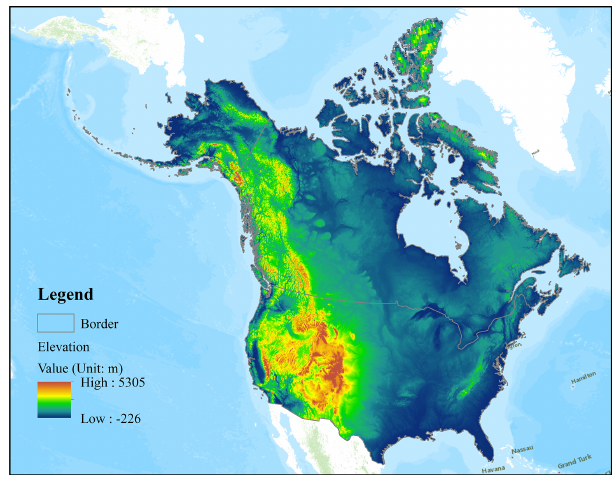
Figure 1. Topographic map of North